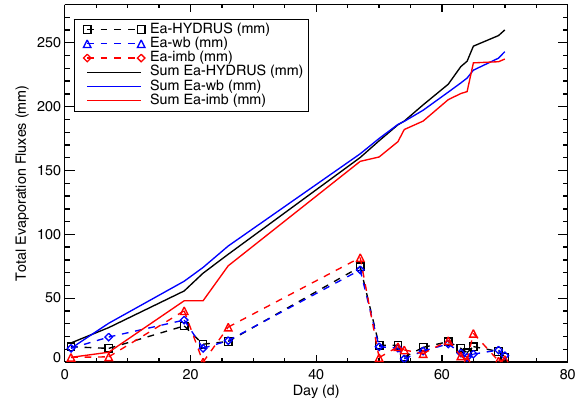
Fig. 7. Comparison of estimated evaporation using three different methods ( E a − HYDRUS evaporation from HYDRUS-1D, E a − imb evaporation from isotope mass balance, E a − wb evaporation from water balance, sum stands for cumulative flux).